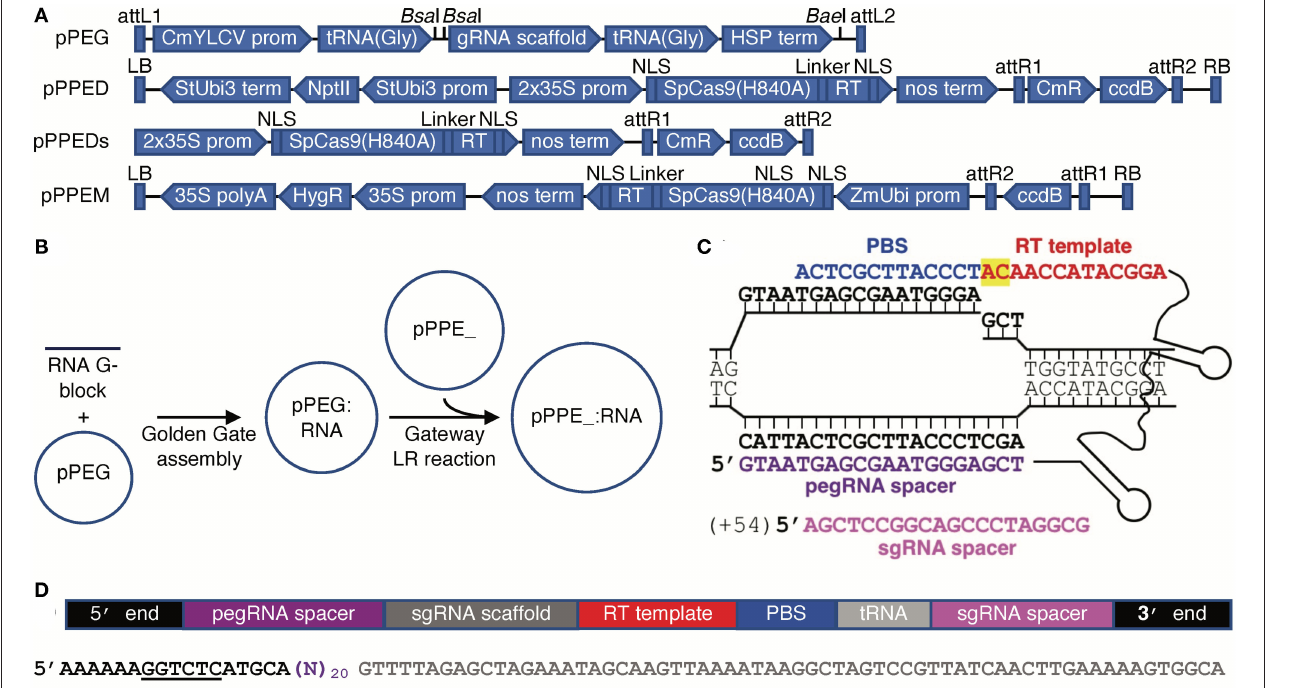
FIGURE 1 | Vectors and construct assembly for PE in plants. (A) Features of each vector (vectors and annotated sequences available at www.addgene.org). (B) Workflow for generating PE constructs. (C) A pegRNA on its target, showing the PBS (blue), RT template (red, with the edit highlighted in yellow), spacer (purple), and nick site, and, for PE3, the sgRNA (magenta) with the position of its nick site relative to the pegRNA-mediated nick in parentheses. (D) Schematic and color-matched sequence of an RNA module including compatible ends for Golden Gate cloning into pPEG ( Bsa I sites underlined), pegRNA spacer, sgRNA scaffold, RT template and PBS (of unspecified lengths, n ), and optionally a tRNA(Gly) and sgRNA